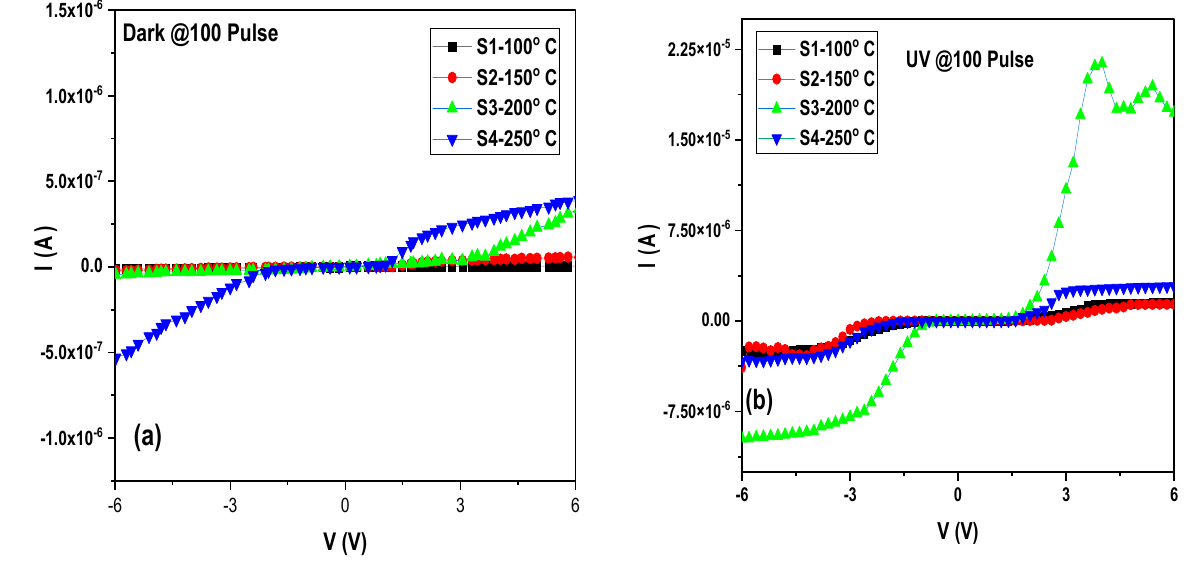
Figure 6. I–V characteristic of MoO 3 /Si heterostructure photodetector under dark ( a ) and UV irradiance ( b ) of the S1, S2, S3, and S4 samples.